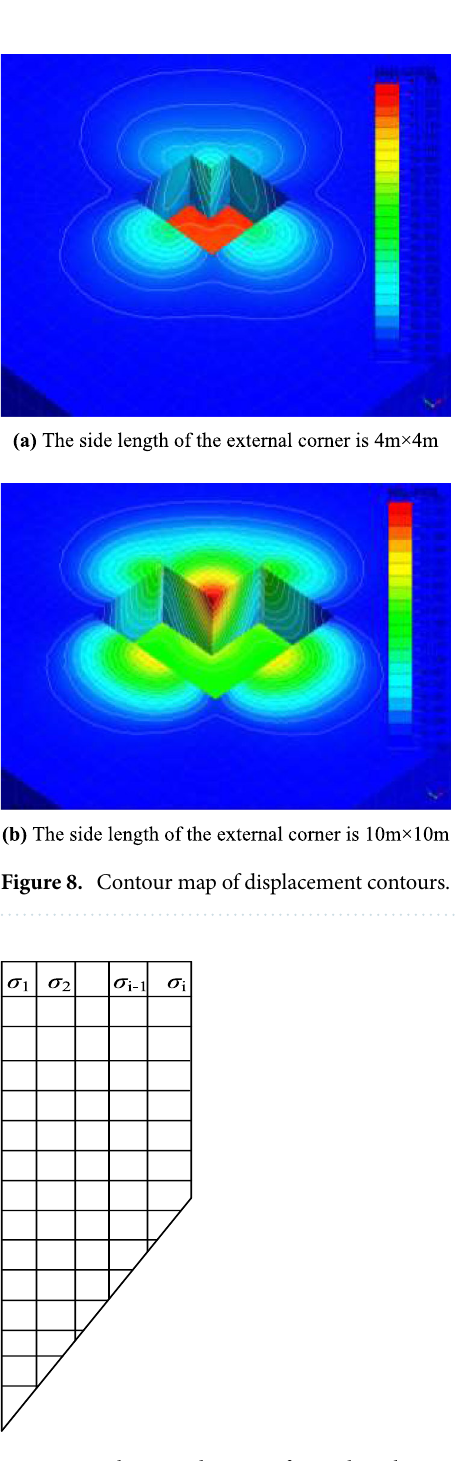
Figure 9. Schematic diagram of partial